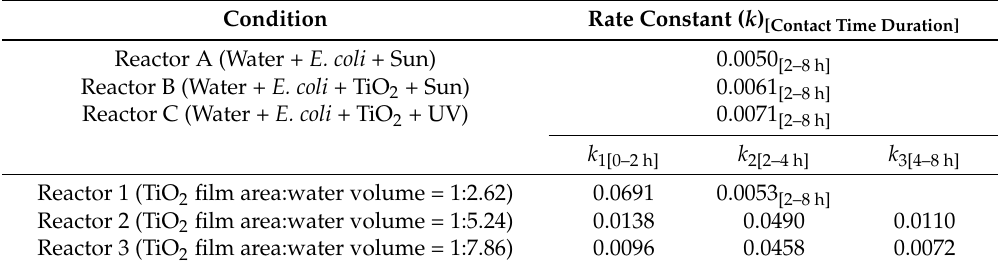
Table 3. Rate constant determined from slope of the plots in Figure 6a,b at each operation period. Condition